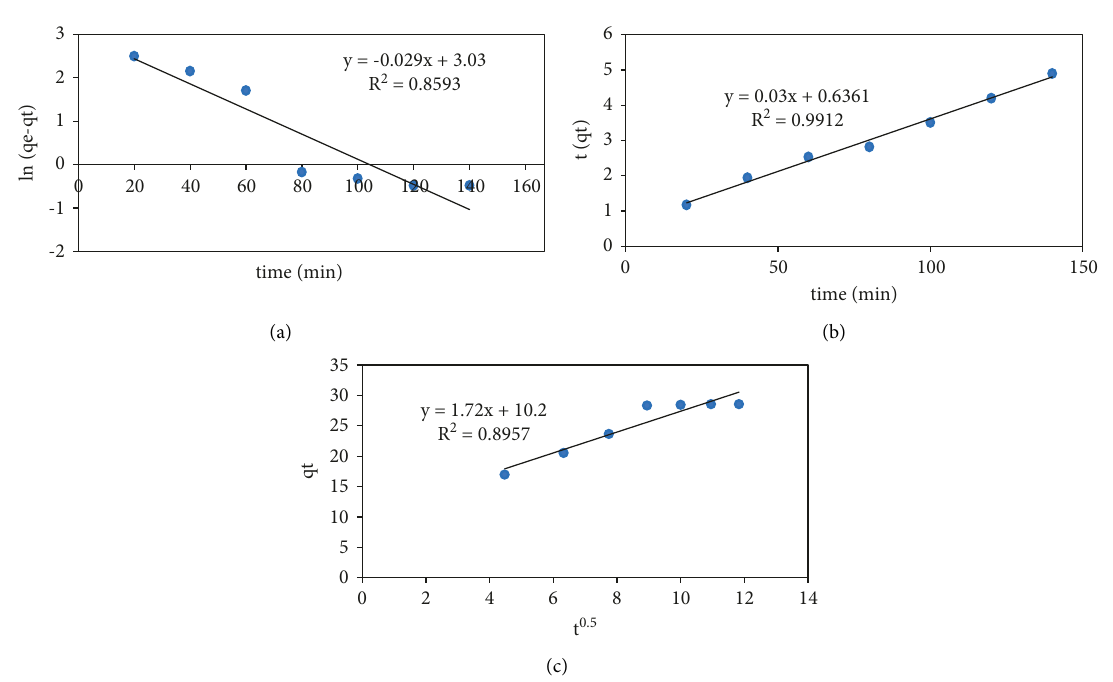
Figure 13: Pseudo-first-order (a), pseudo-second-order (b), and intraparticle diffusion (c) kinetic model plots.